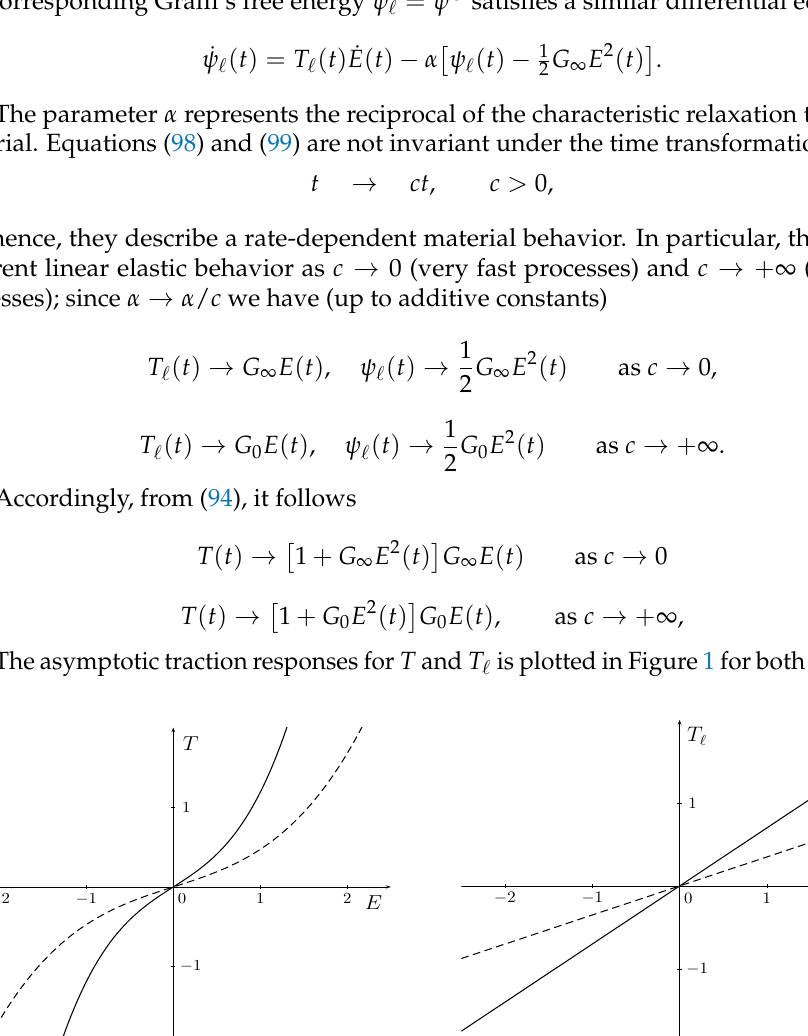
Figure 1. Asymptotic responses in the ( E , T ) -plane as c linear (on the right) and nonlinear (on the left) constitutive relations with G 0 = 0.7 and G ∞ =